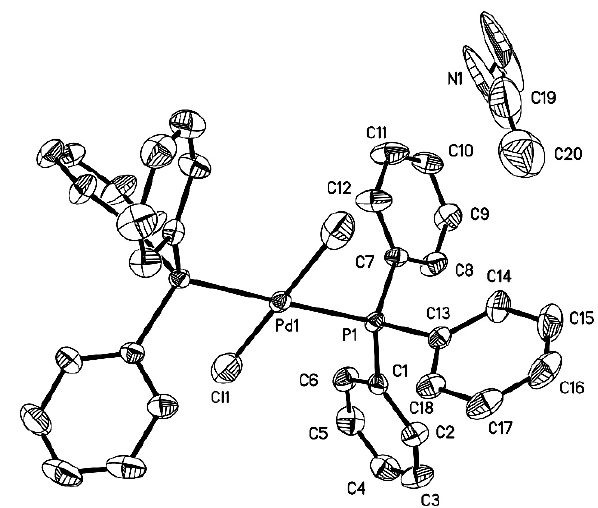
Table 1. Data collection and handling.